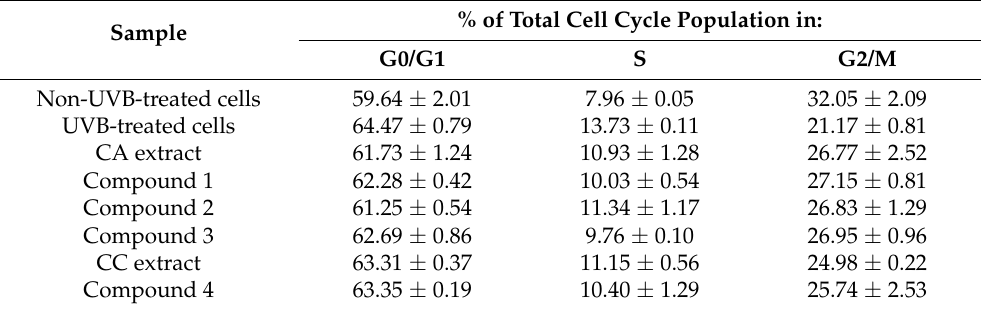
Table 3. Cell cycle distribution of the CA and CC extracts and isolated compounds 1 – 4 treated HaCaT cells at 24 h after the tenth UVB exposure (100 mJ/cm 2